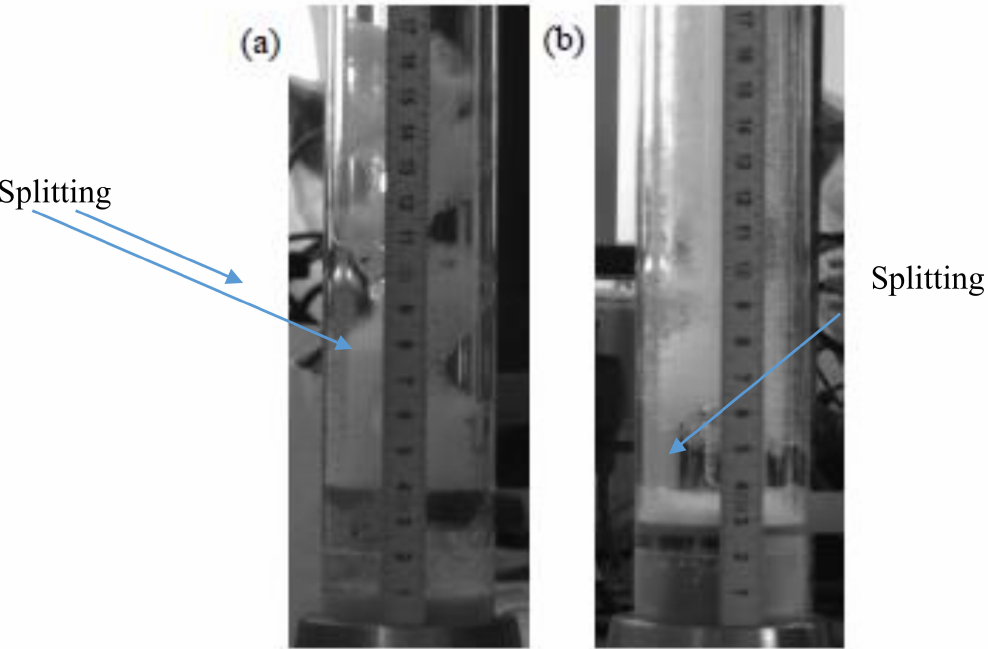
Figure 9. Examples of splitting caused by coalescing at ( a ) 1 CMC SDS diluted with distilled water with capillaries and sponge and ( b ) 10 CMC SDS diluted with distilled water with capillaries. The splitting is indicated by the arrow showing the points where the foam has